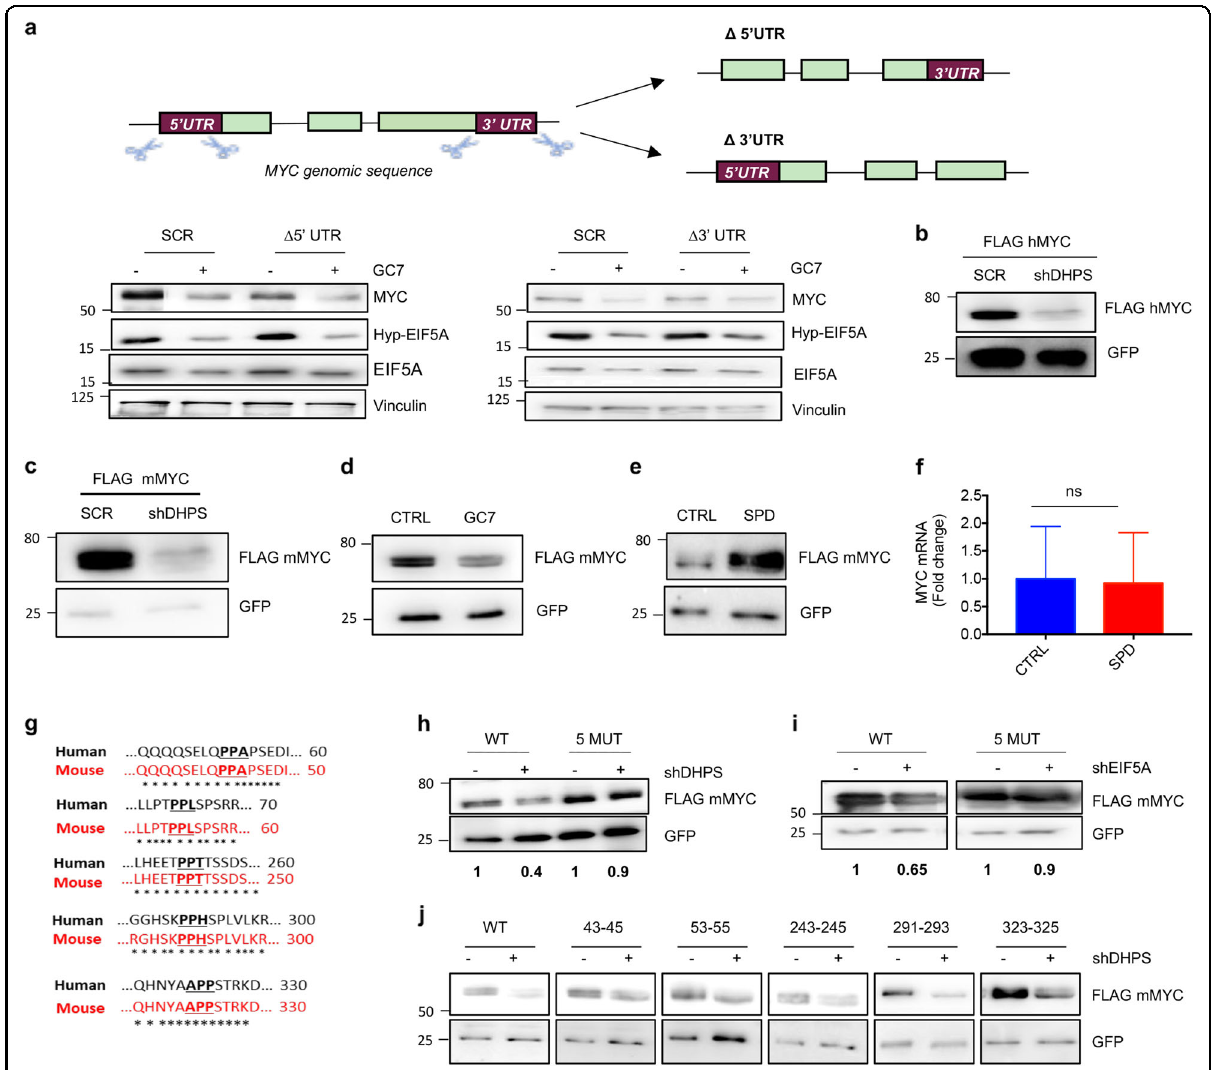
Fig. 4 EIF5A regulates MYC translation at PPA sites in the coding region. a Schematic representation of CRISPR/Cas9 strategy used to delete 5 ′ - or 3 ′ -UTRs from MYC gene in HCT116 cells ( Δ 5 ′ UTR and Δ 3 ′ UTR clones, respectively). Western blotting of MYC, Hyp-EIF5A, EIF5A, and Vinculin (loading control) in scrambled (SCR) and Δ 5 ′ UTR clones (left) or in SCR and Δ 3 ′ UTR (right) clones treated with 100 μ M GC7 or vehicle for 24 h. b Western blotting using FLAG and GFP antibody in HCT116 cells infected with SCR or shDHPS lentiviruses and co-transfected with vectors expressing FLAG hMYC and GFP. c Western blotting using FLAG and GFP antisera in HCT116 cells infected with SCR or shDHPS lentiviruses and co- transfected with vectors expressing FLAG mMYC and GFP. d Western blot analysis of FLAG and GFP in HCT116 cells transfected with FLAG mMYC and GFP vectors and treated with 100 µM GC7 for 48 h. e Immunoblot analysis of FLAG and GFP co-transfected with FLAG mMYC and GFP vectors, in polyamines-depleted HCT116 cells for 3 days by using 1 mM DFMO incubation and then treated with 10 μ M Spermidine for the last 16 h. f MYC mRNA levels from e . Data were normalized by β -actin mRNA ( n = 3). g Alignment of human (black) and mouse (red) MYC aminoacidic sequences at the identi fi ed pausing motifs. h Western blot analysis of FLAG and GFP in HCT116 cells infected with shDHPS or SCR and transfected with FLAG mMYC WT or mMYC 5 MUT and GFP as control for 24 h. Densitometric analysis of MYC/GFP protein levels is shown at the bottom of each lane. i Immunoblot with FLAG and GFP antisera in EIF5A-de fi cient (shEIF5A) or control (SCR) HCT116 cells co-transfected for 24 h with plasmids expressing GFP and FLAG mMYC, WT or mutated in the putative fi ve pausing motifs (mMYC 5 MUT). Densitometric analysis of MYC/GFP protein levels is shown at the bottom of each lane. j Immunoblot with FLAG and GFP antisera in DHPS-de fi cient (shDHPS) or control (SCR) HCT116 cells co-transfected for 24 h with plasmids expressing GFP and FLAG mMYC, WT or mutated in the indicated individual pausing